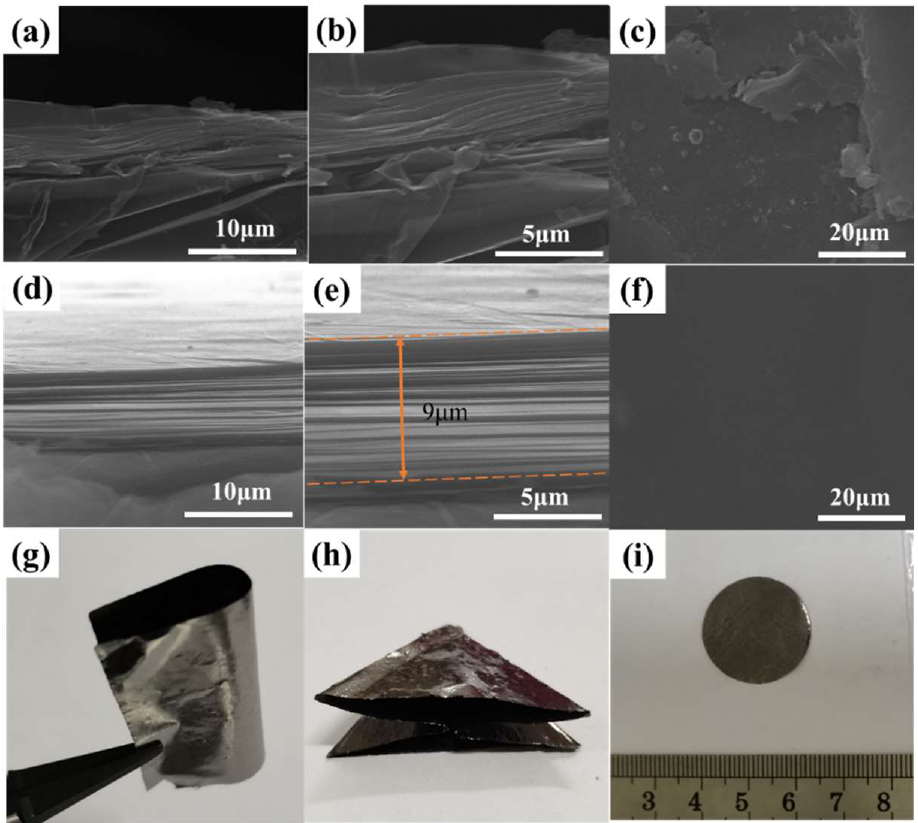
Figure 5. ( a , b ) SEM images of g-TIPI film cross-section; ( c ) surface images of g-TIPI film; ( d , e ) SEM images of g-CIPI-0.72% film cross-section; ( f ) surface images of g-CIPI-0.72% film; ( g – i ) optical photograph of graphited films. Table 2. Two-dimensopmal peak fitting, R, I D /I G and La values of g-TIPI and g-CIPI films. 2D Peak